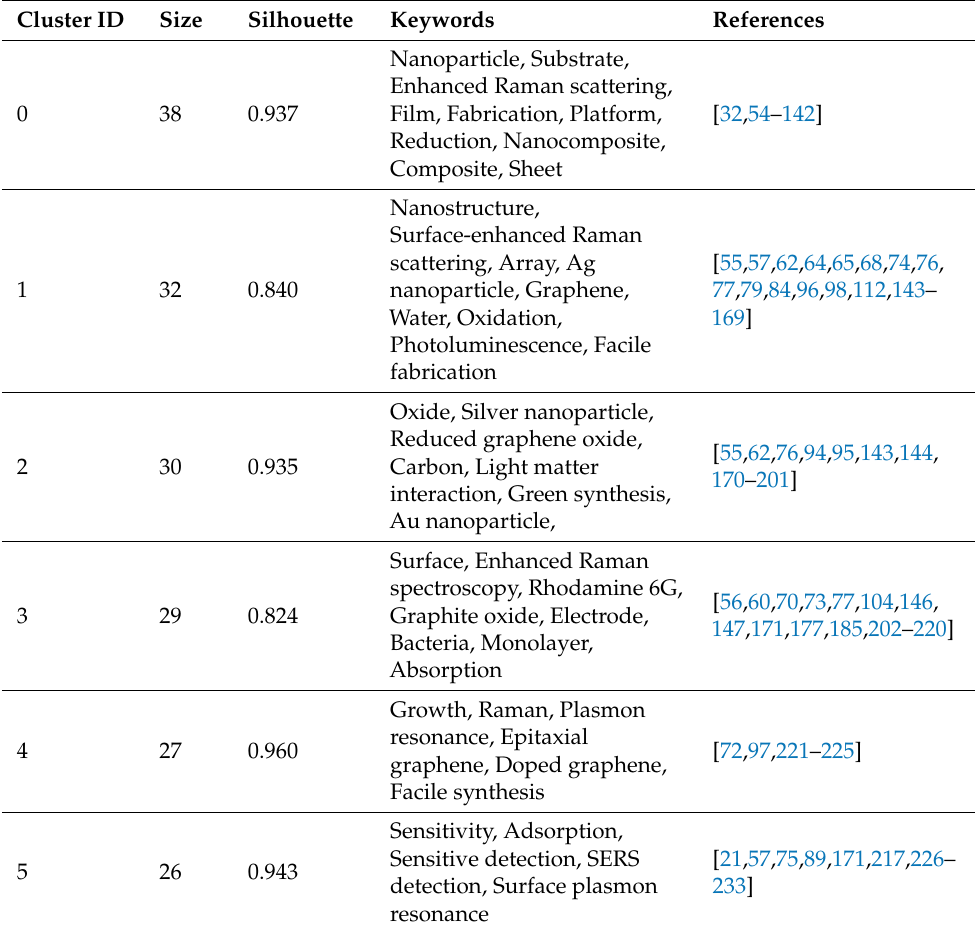
Figure 8. A grouping of keywords for graphene ‐ based SERS. Table 6. Knowledge clusters in the field of graphene-based SERS on keyword co-occurrences for each